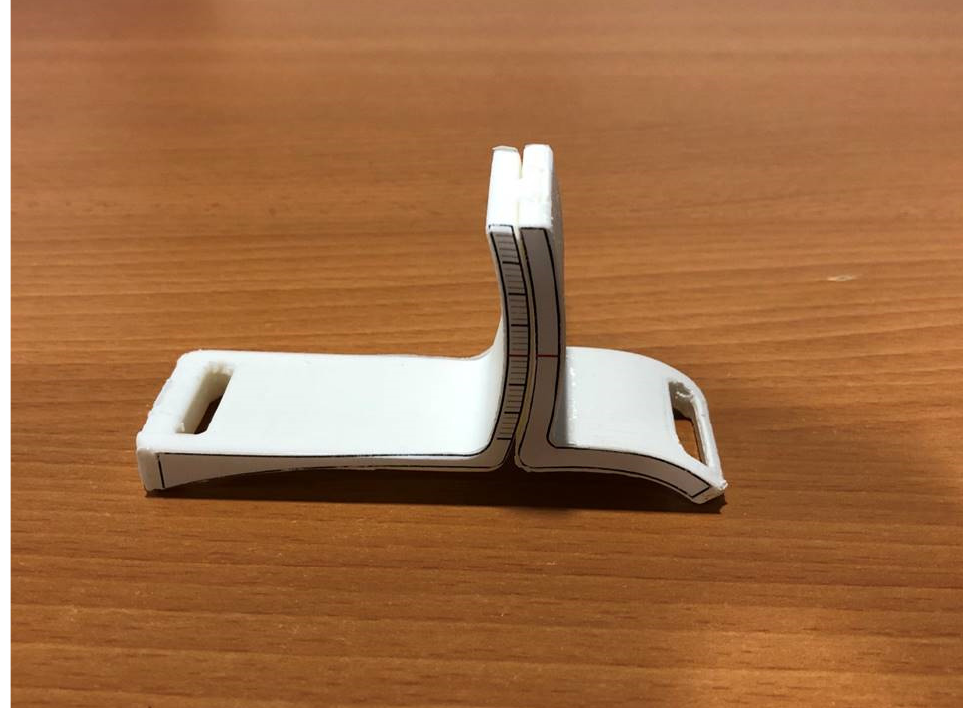
Figure 1. The new instrument for the measurement of the first ray mobility.